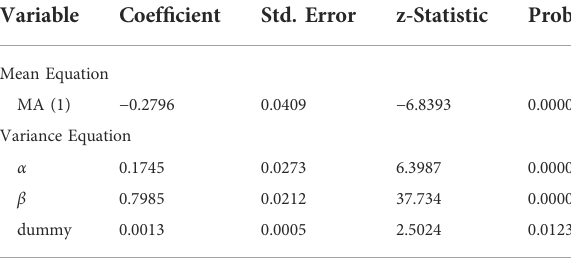
TABLE 12 Parameter estimates for the MA (1) — GARCH (1, 1) model for Hubei spot returns with structural breaks from 1 July 2019, to 30 July 2021.